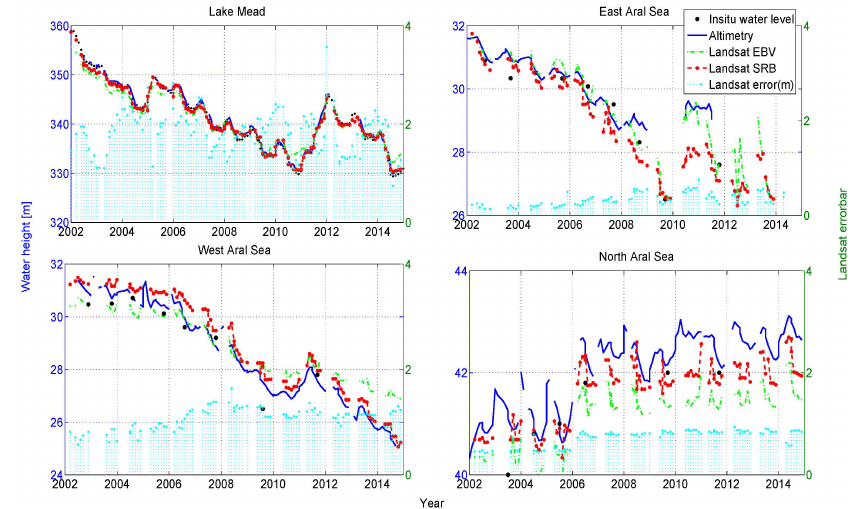
Figure 7. ( Left ) Water height observed by altimetry, Landsat: entire boundary vector (EBV), selected region boundary (SEB) and in situ ; ( Right ) error bar for Landsat-SRB water height. The water heights derived by the Landsat-SRB (Figure 7: red dashed line) from 2D Landsat masks are in very good agreement with the observed heights from satellite altimetry for all of the